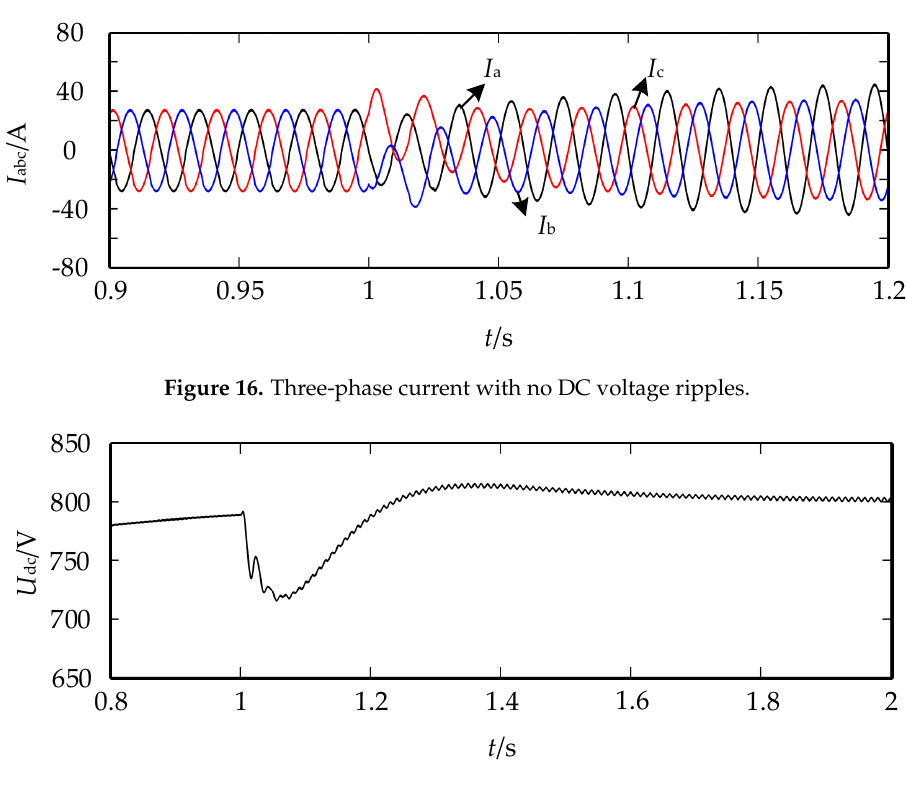
Figure 17. DC bus voltage with no ripples.